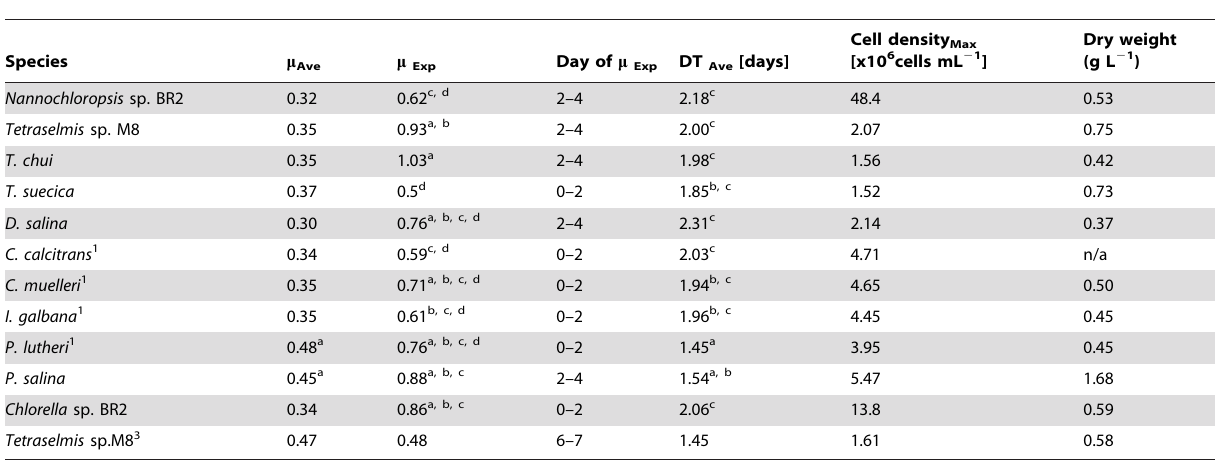
Table 2. Growth rate analysis of eleven microalgae strains during growth phase (7 days) of batch culture.